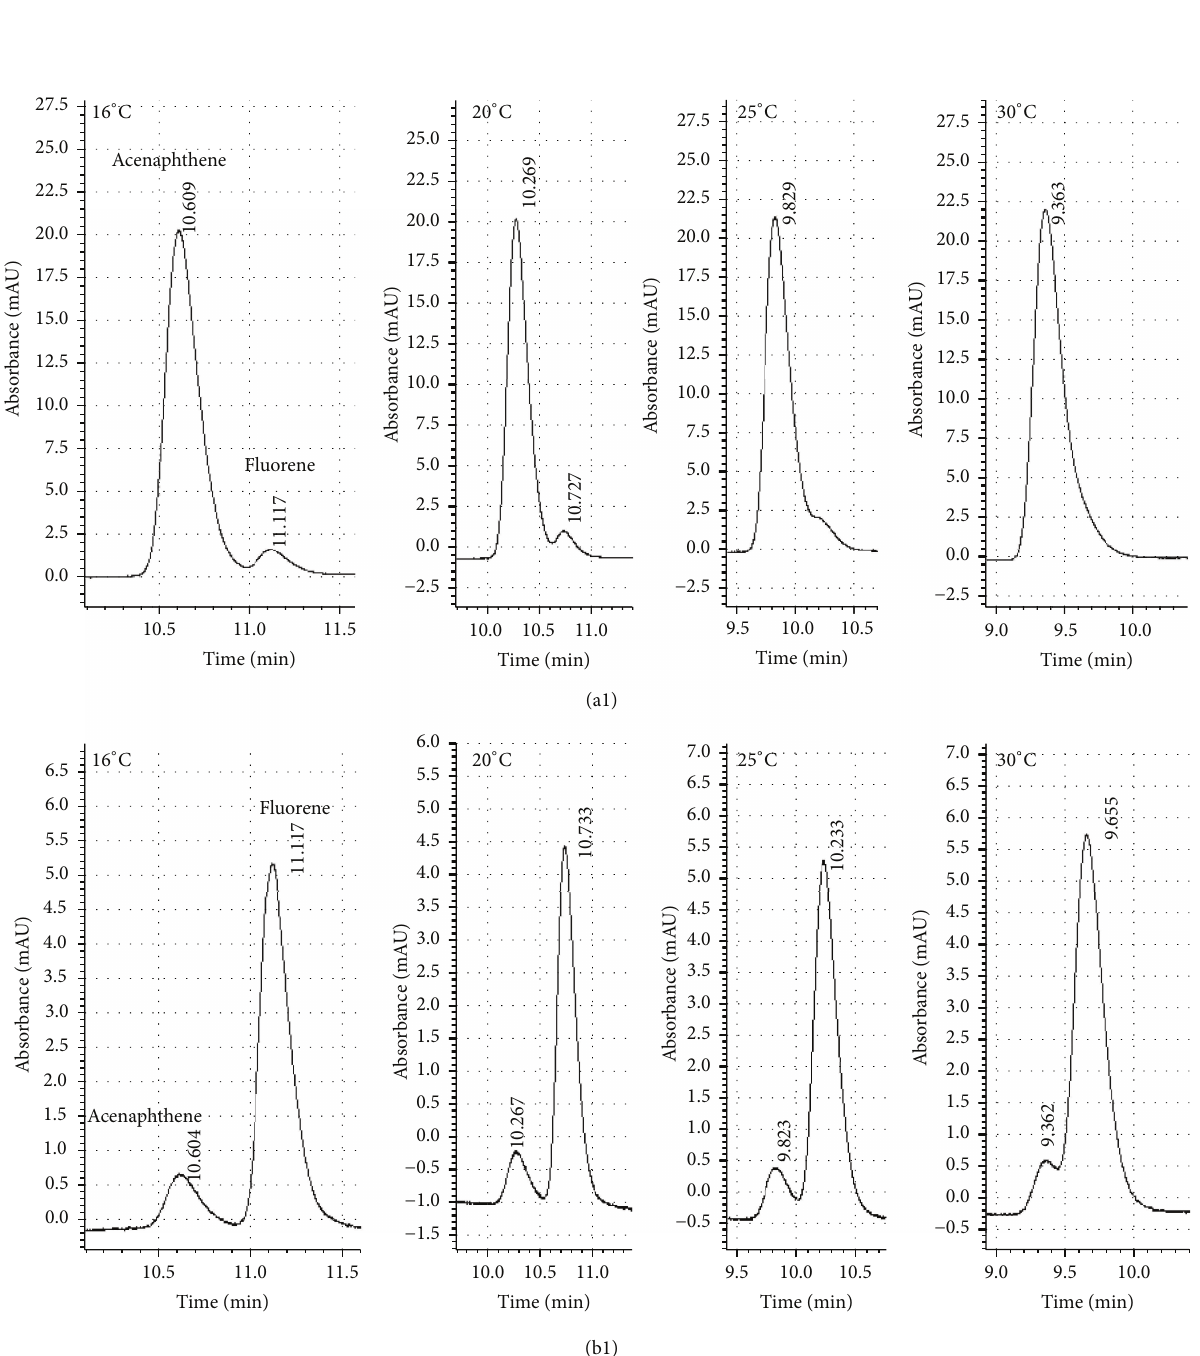
Figure 2: Effect of the temperature on the separation of fluorene and acenaphthene using the Supelcosil LC-PAH column; (a1) at 227 nm; (b1) at